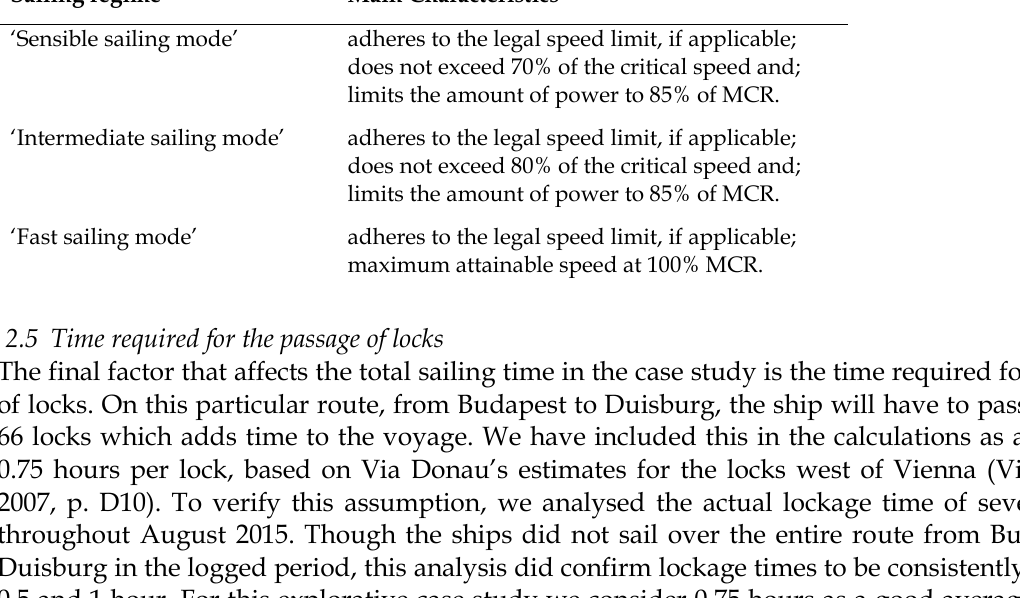
Table 2. Summary of sailing